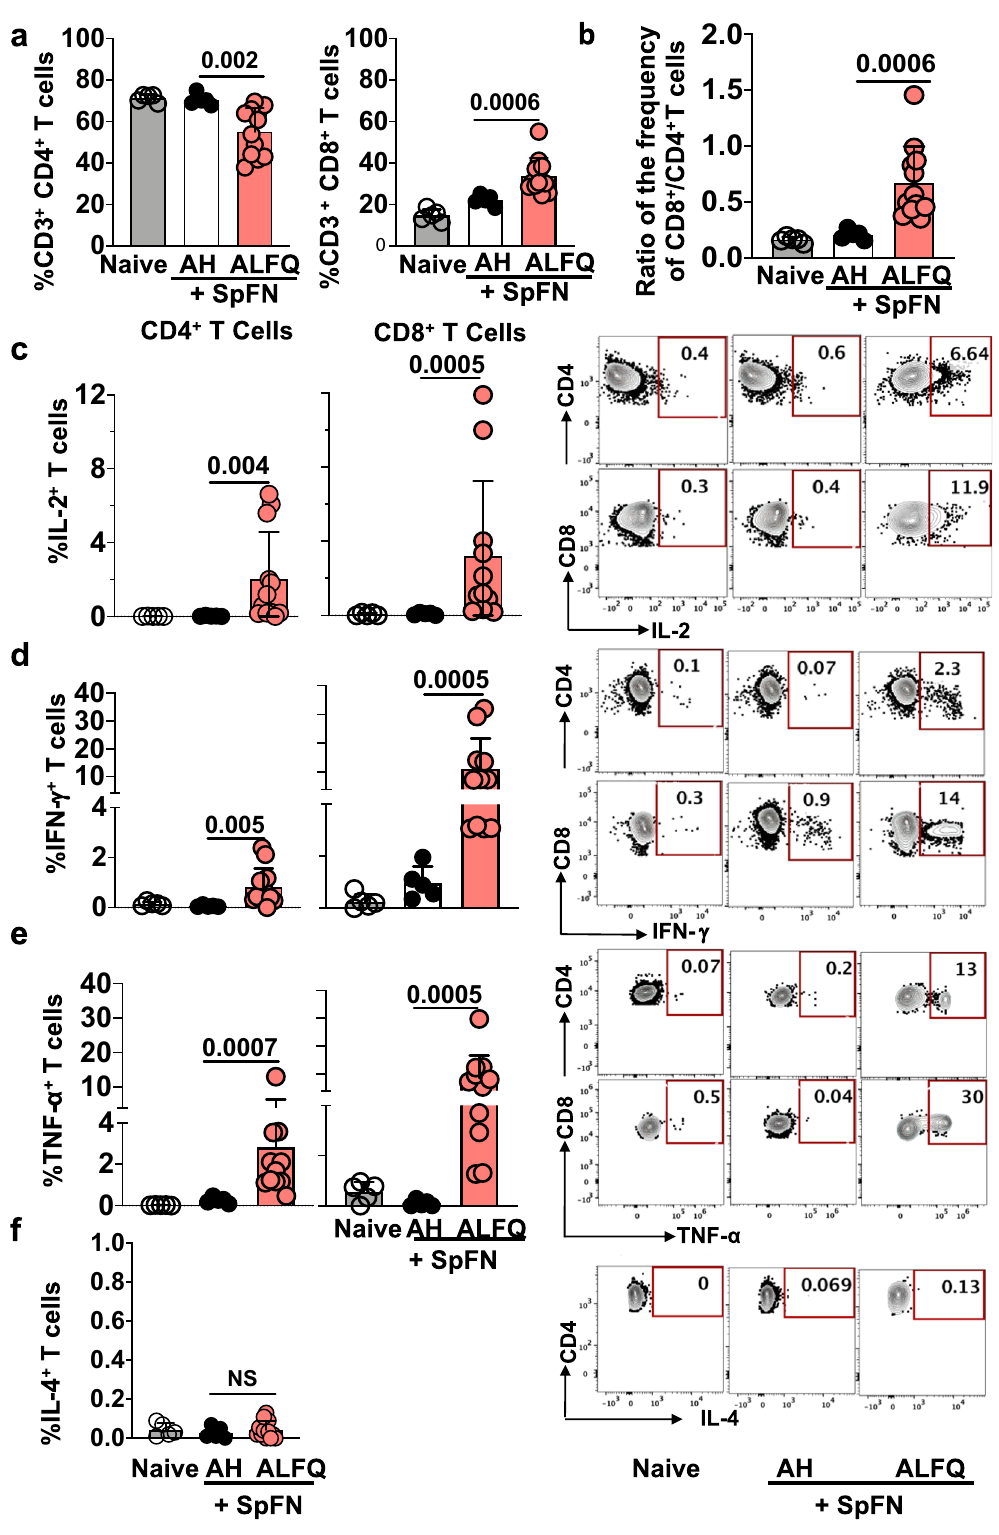
Fig. 5 T cell responses in splenocytes of mice in response to SpFN vaccine at week 6 following prime-boost vaccination. a Frequency of total CD4 + and CD8 + T cells. b Ratio of the frequency of total CD8 + /CD4 + T cells. Bar graphs and representative fl ow plots demonstrate cytokine c IL-2, d IFN- γ , e TNF- α secreting CD4 + and CD8 + T cells, and f IL-4 secreting CD4 + T cells. Dots represent data from individual mice (naive: n = 5; AH: n = 5; ALFQ: n = 11, from two independent experiments). Bars represent mean + s.d. Statistical signi fi cance between